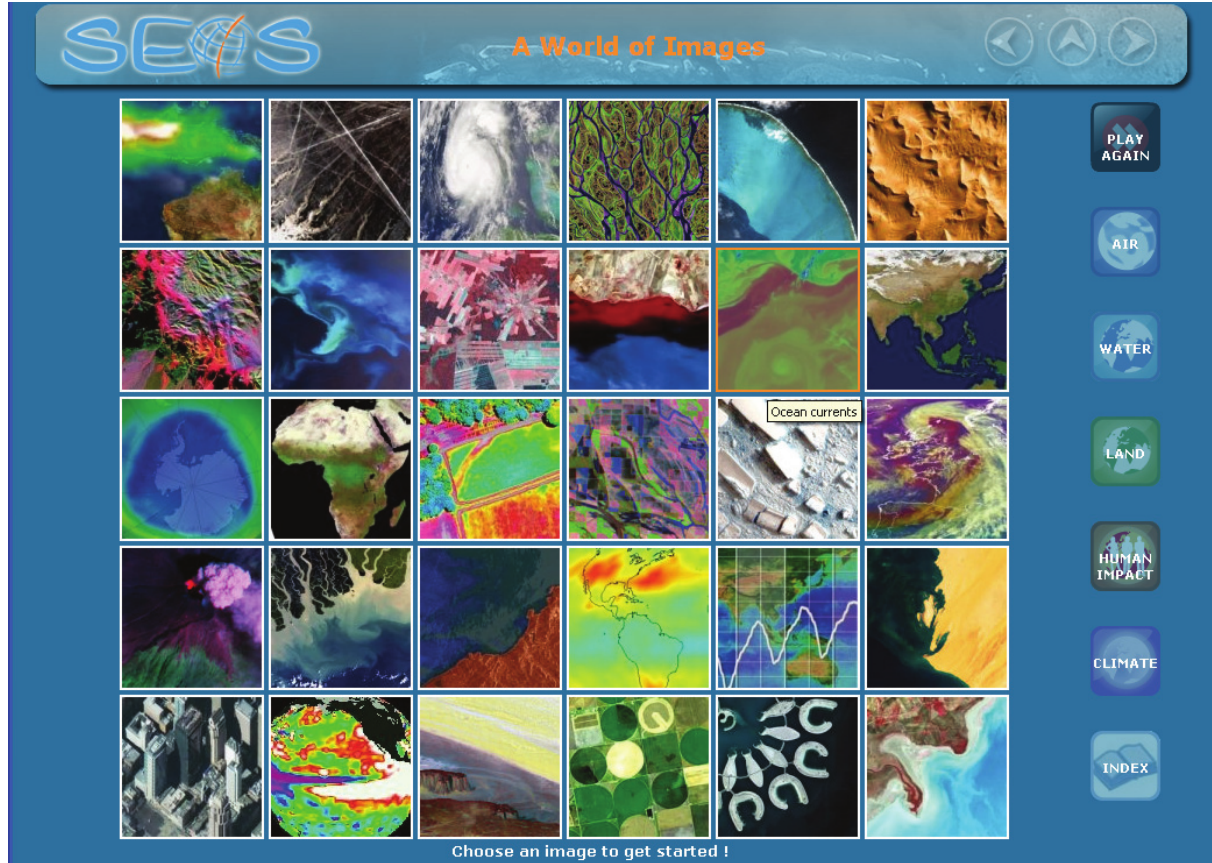
Figure 2: A mosaic of satellite images in the tutorial A World of Images , showing an overview of all